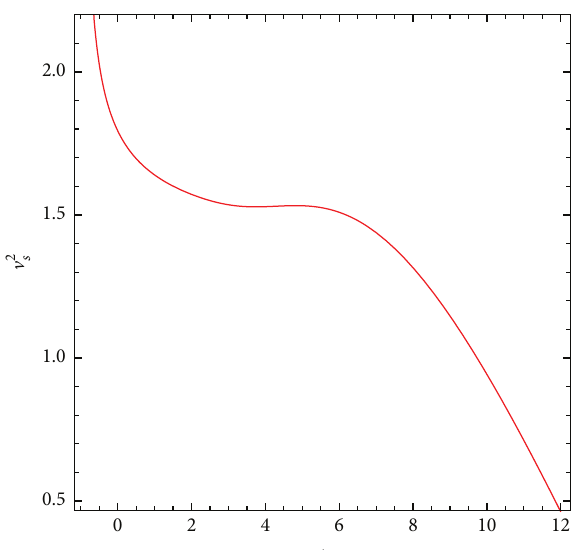
Figure 15: Statefinder parameters for the choice of 𝑓(𝑇) = 𝛿 exp (𝜉𝑇) .